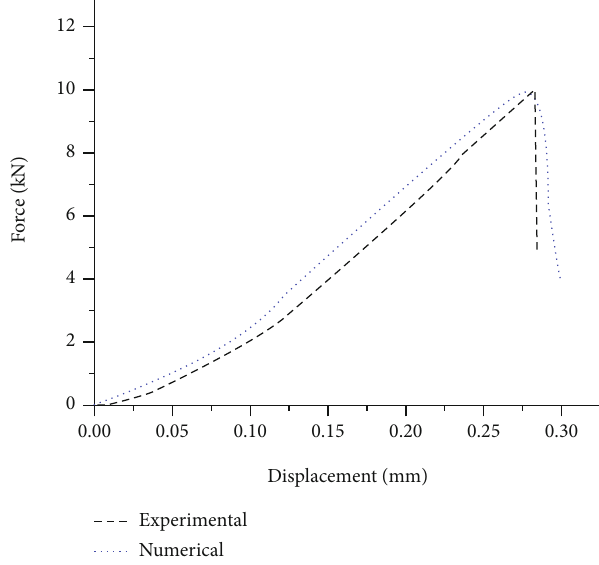
Figure 8: Comparison of the force versus displacement curve between the experiment and